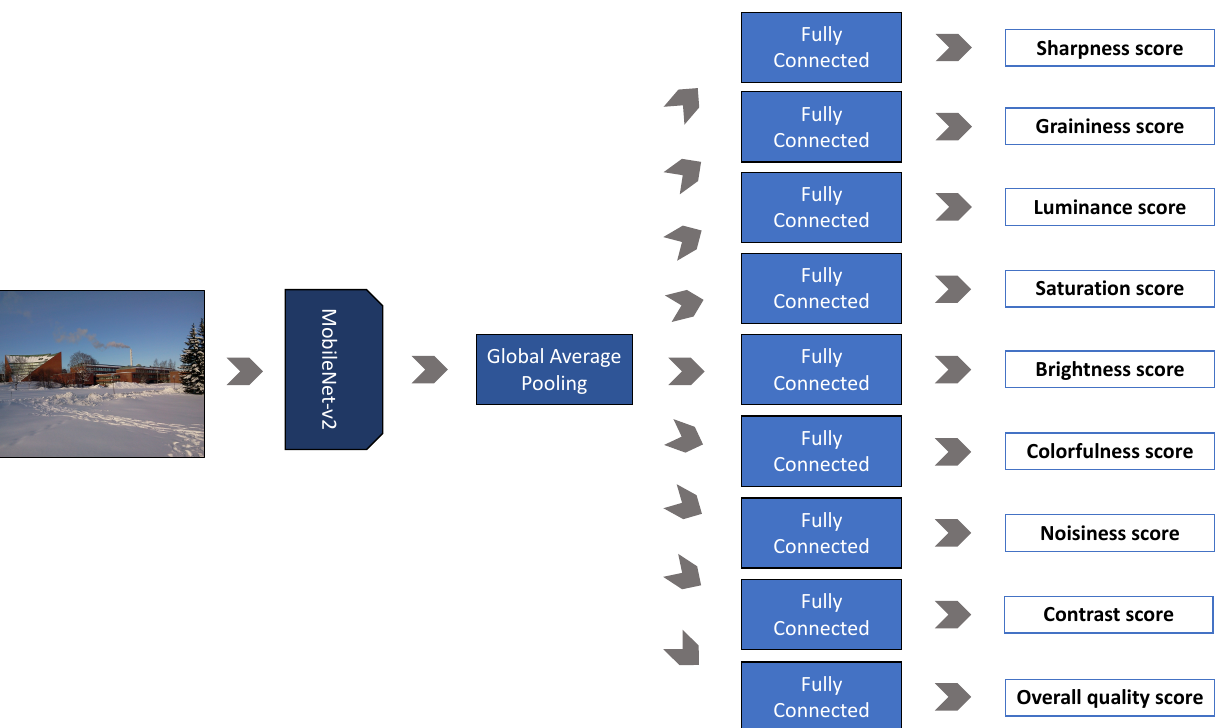
Figure 3. Definition of the Extractor-Q. Given an image of any size, Extractor-Q estimates the overall quality score as well as the scores for eight quality attributes, namely, brightness, colorfulness, contrast, graininess, luminance, noisiness, and sharpness, and color saturation. It consists of a MobileNet-v2 followed by a Global Average Pooling (GAP) level and a fully connected (FC) level for each one of the previously mentioned